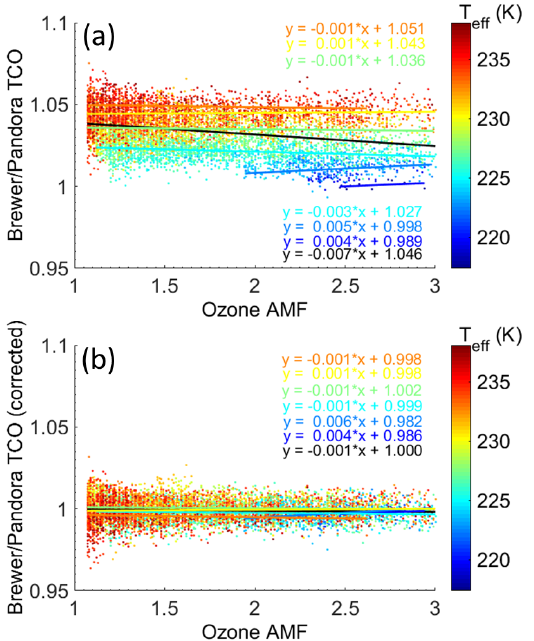
Figure 14. Brewer no. 14 / Pandora no. 103 TCO ratio vs. ozone air mass factor: (a) before and (b) after applying the Pandora temper- ature dependence correction. The points are grouped by effective temperature (from 215 to 240K, in 5K bins), and the linear fits for each group are colour-coded. The black line and linear fit are for the whole dataset.